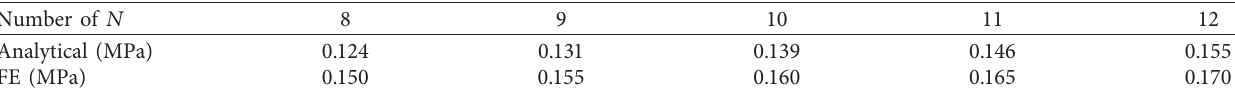
Table 2: The quasi-static collapse stress of DHHs under uniaxial compression in the z direction, N � 8 ∼ 12 and ρ � 5%. Number of